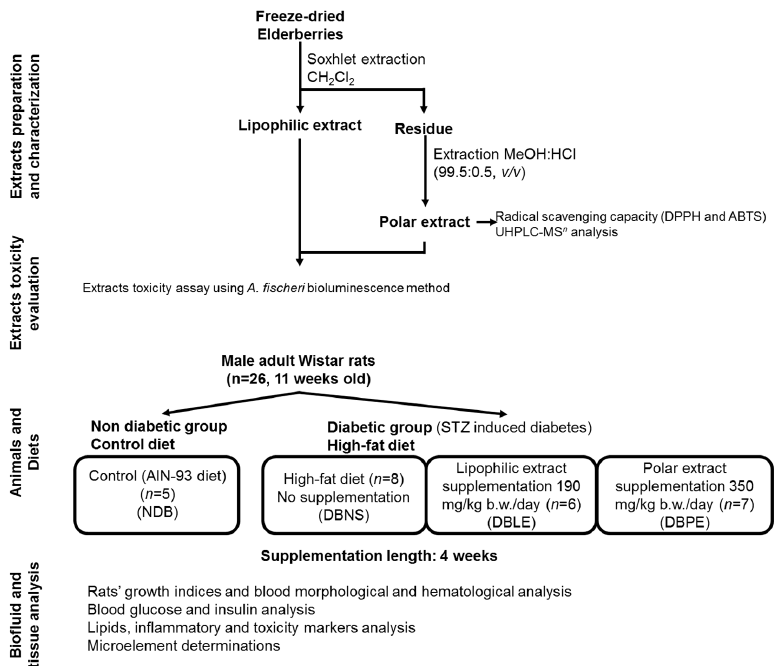
Figure 1. Main stages of elderberry extract preparation, partial characterization, and toxicity evaluation; followed by Wistar rat elderberry extract supplementation and biofluid and tissue analysis. NDB: non-diabetic group; DBNS: diabetic group/not supplemented; DBLE: diabetic group/supplemented with lipophilic extract; and DBPE: diabetic group/supplemented with polar extract. UHPLC-MS n : ultra-high-pressure liquid chromatography-tandem mass spectrometry, DPPH: 2,2-diphenyl-1-picrylhydrazyl, ABTS: 2,2 ′ -Azino-bis(3-ethylbenzothiazoline-6-sulphonic acid).